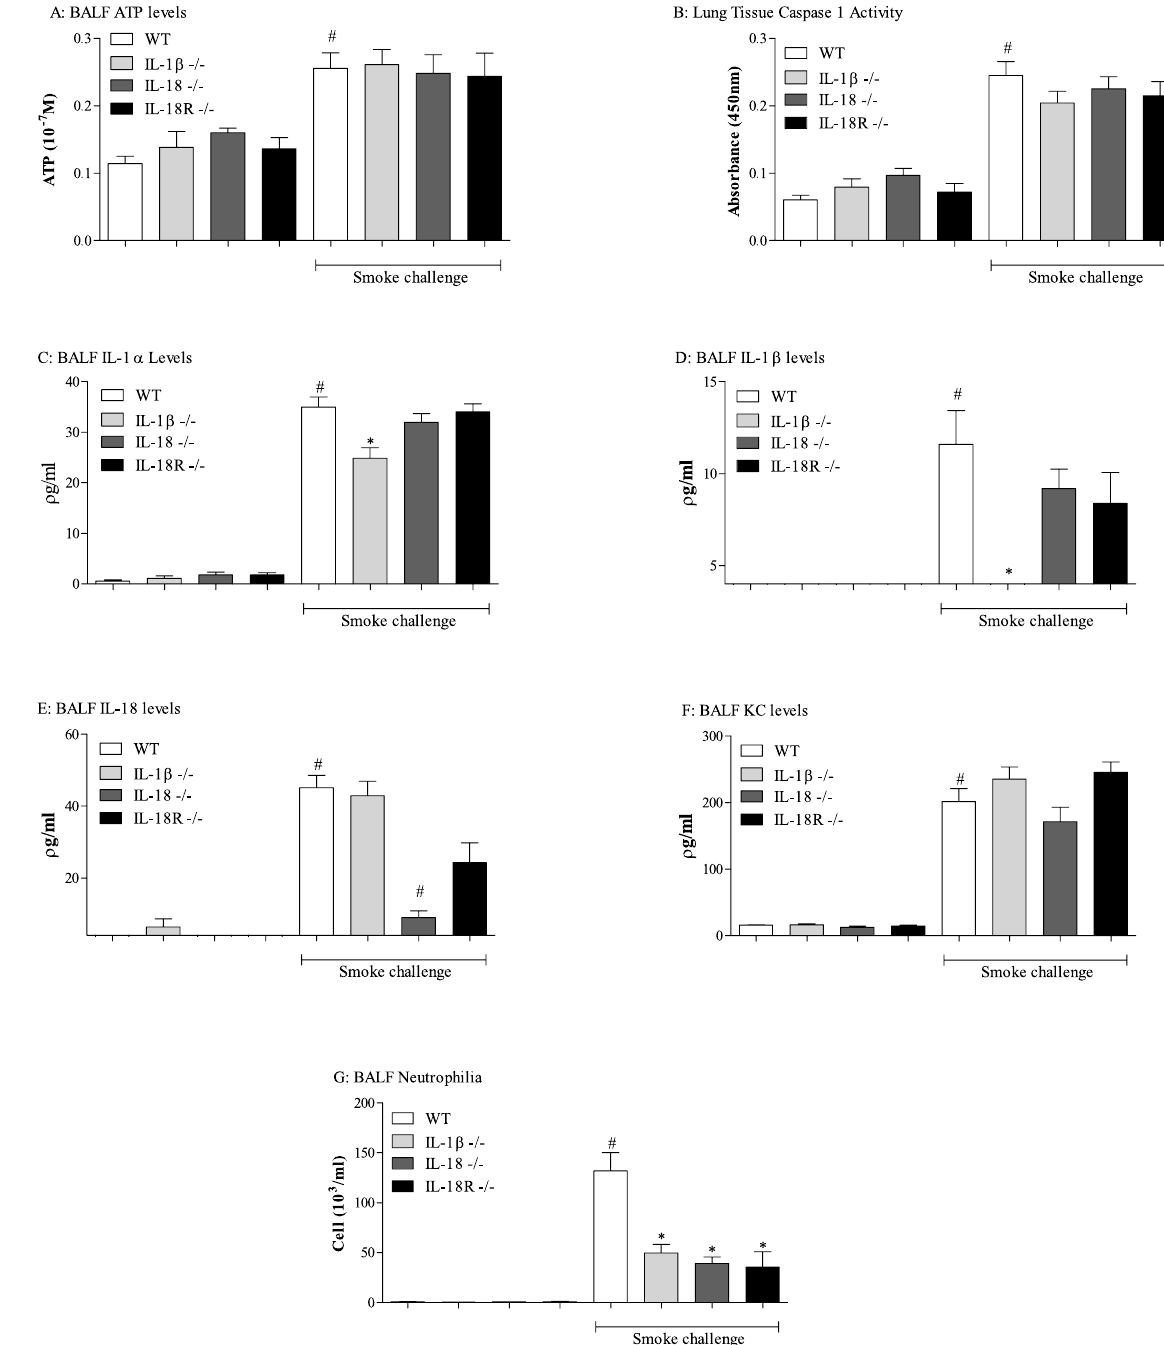
Figure 4. Role of the IL-1 family cytokines in CS-driven model. IL-1 b , IL-18 or IL-18R -/- mice were exposed to CS or room air (control) twice daily for 3 consecutive days alongside wild-type controls. BALF and lung tissue was collected 24 hours after the last exposure for measurement of ATP (A), caspase 1 activity (B), IL-1 a (C), IL-1 b (D), IL-18 (E), KC (F) and neutrophil (G) levels. Data are represented as mean 6 S.E.M. for n=8 animals in each group. Statistical significance was determined using Mann-Whitney U test. # =P , 0.05, denoting a significant difference between the smoke exposed and air exposed wild-type groups; * =P , 0.05, denoting a significant difference between the smoke exposed knock-outs and wild-types (one-way ANOVA).